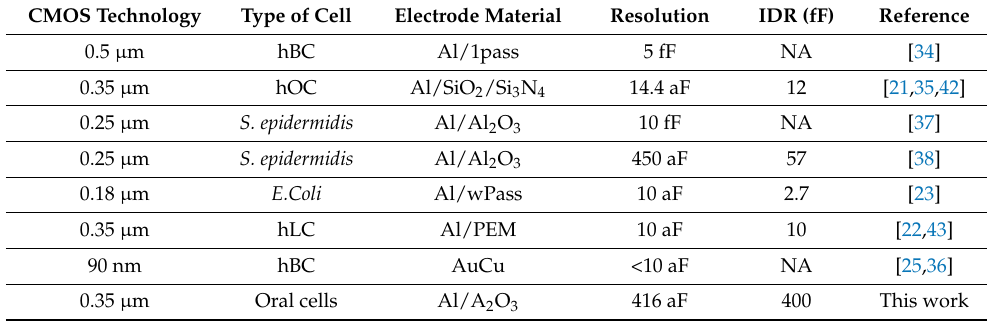
Table 1. Comparison of the capacitive sensors reported for cellular